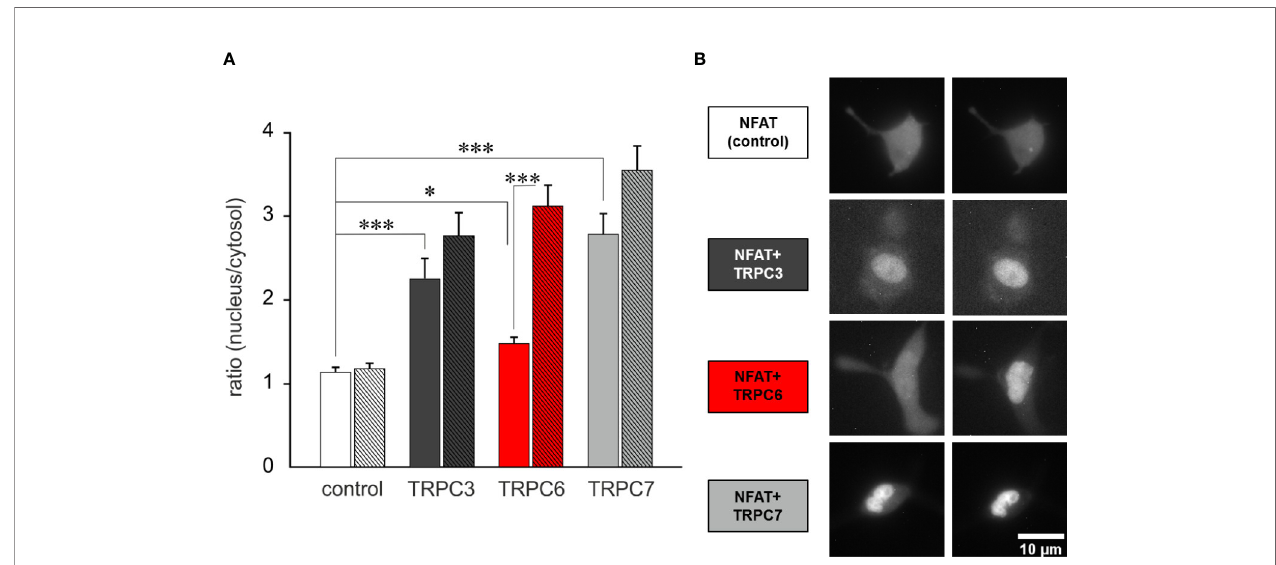
FIGURE 3 | TRPC6 expression enables OptoBI-1-mediated control of NFAT1 activity in RBL-2H3 cells by light. (A) NFAT1 nuclear translocation in RBL-2H3 cells overexpressing either mCherry-NFAT1 only (control; white, n = 30) or mCherry-NFAT1 along with YFP-TRPC3 (black, n=17), YFP-TRPC6 (red, n = 31) or with TRPC7-CFP (gray, n = 21). Mean ± SEM nucleus/cytosol fl uorescence intensity ratio. The translocation of mCherry-NFAT1 was monitored during OptoBI-1 photoconversion, applying three photocycles of illumination (three Flashes) as indicated. Statistical signi fi cance was tested by One-Way ANOVA (Holm – Sidak test for normally distributed values) or One-Way ANOVA for Ranks (Dunn ’ s test for non-normally distributed values), *p < 0.05, ***p < 0.001, if not indicated — not signi fi cant (p > 0.05). (B) Images of NFAT1 translocation in RBL-2H3 cells expressing mCherry-NFAT1 only (control; white) or coexpressing mCherry-NFAT1 and YFP-TRPC3 (black), YFP-TRPC6 (red) or TRPC7-CFP (grey) before (0 min) and after (12 min) three cycles of UV (365 nm, 10 s) and blue light (430 nm, 10 s) illuminations. Scale bar represents 5